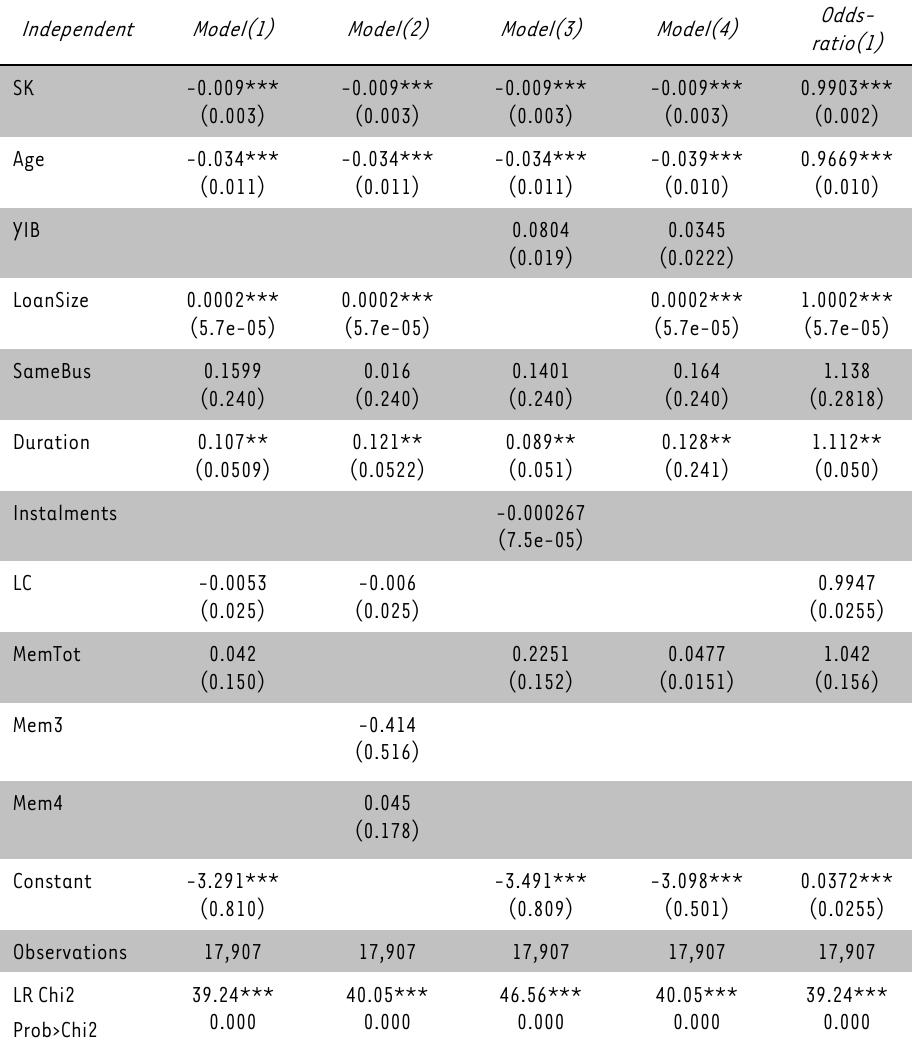
TABLE 6: SEF Logit Regression Results: Dependent variable